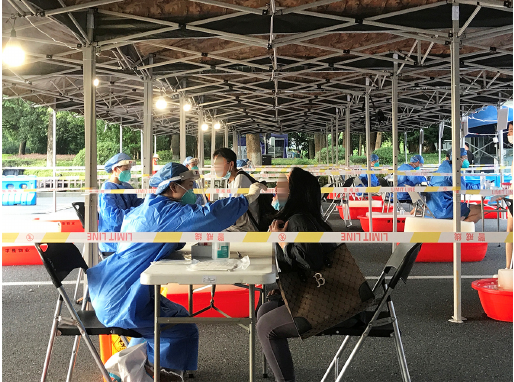
Figure A3. Fences around Zijingang Campus and separated campus couples (photo taken on 5 December 2021).